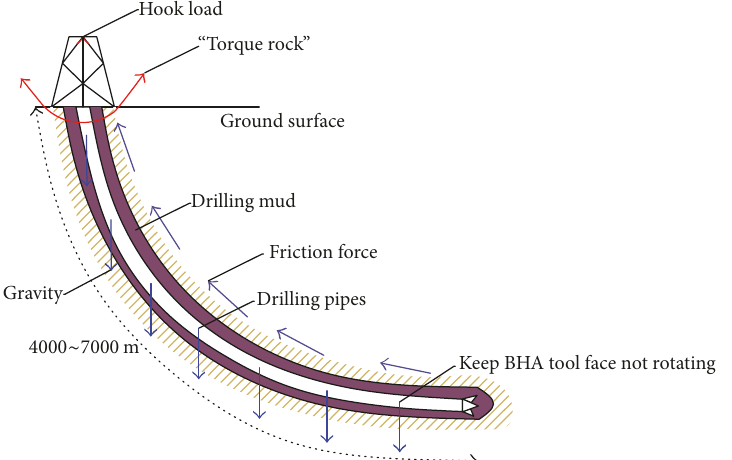
Figure 1: Schematic diagram of “torque